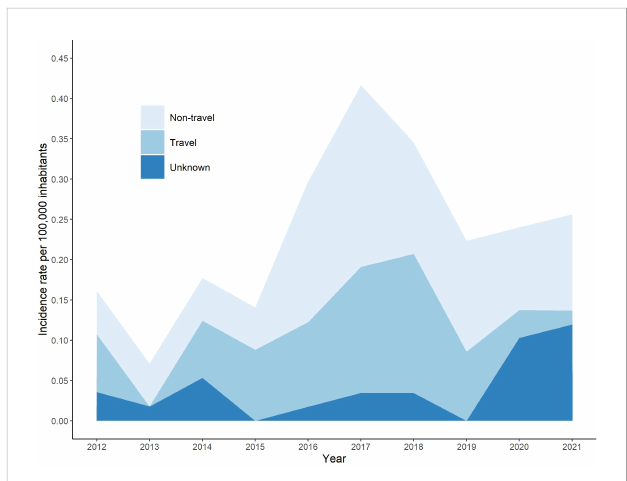
FIGURE 1 Annual incidence rate of leptospirosis per 100,000 inhabitants by year and reported travel-related exposure status in Denmark,